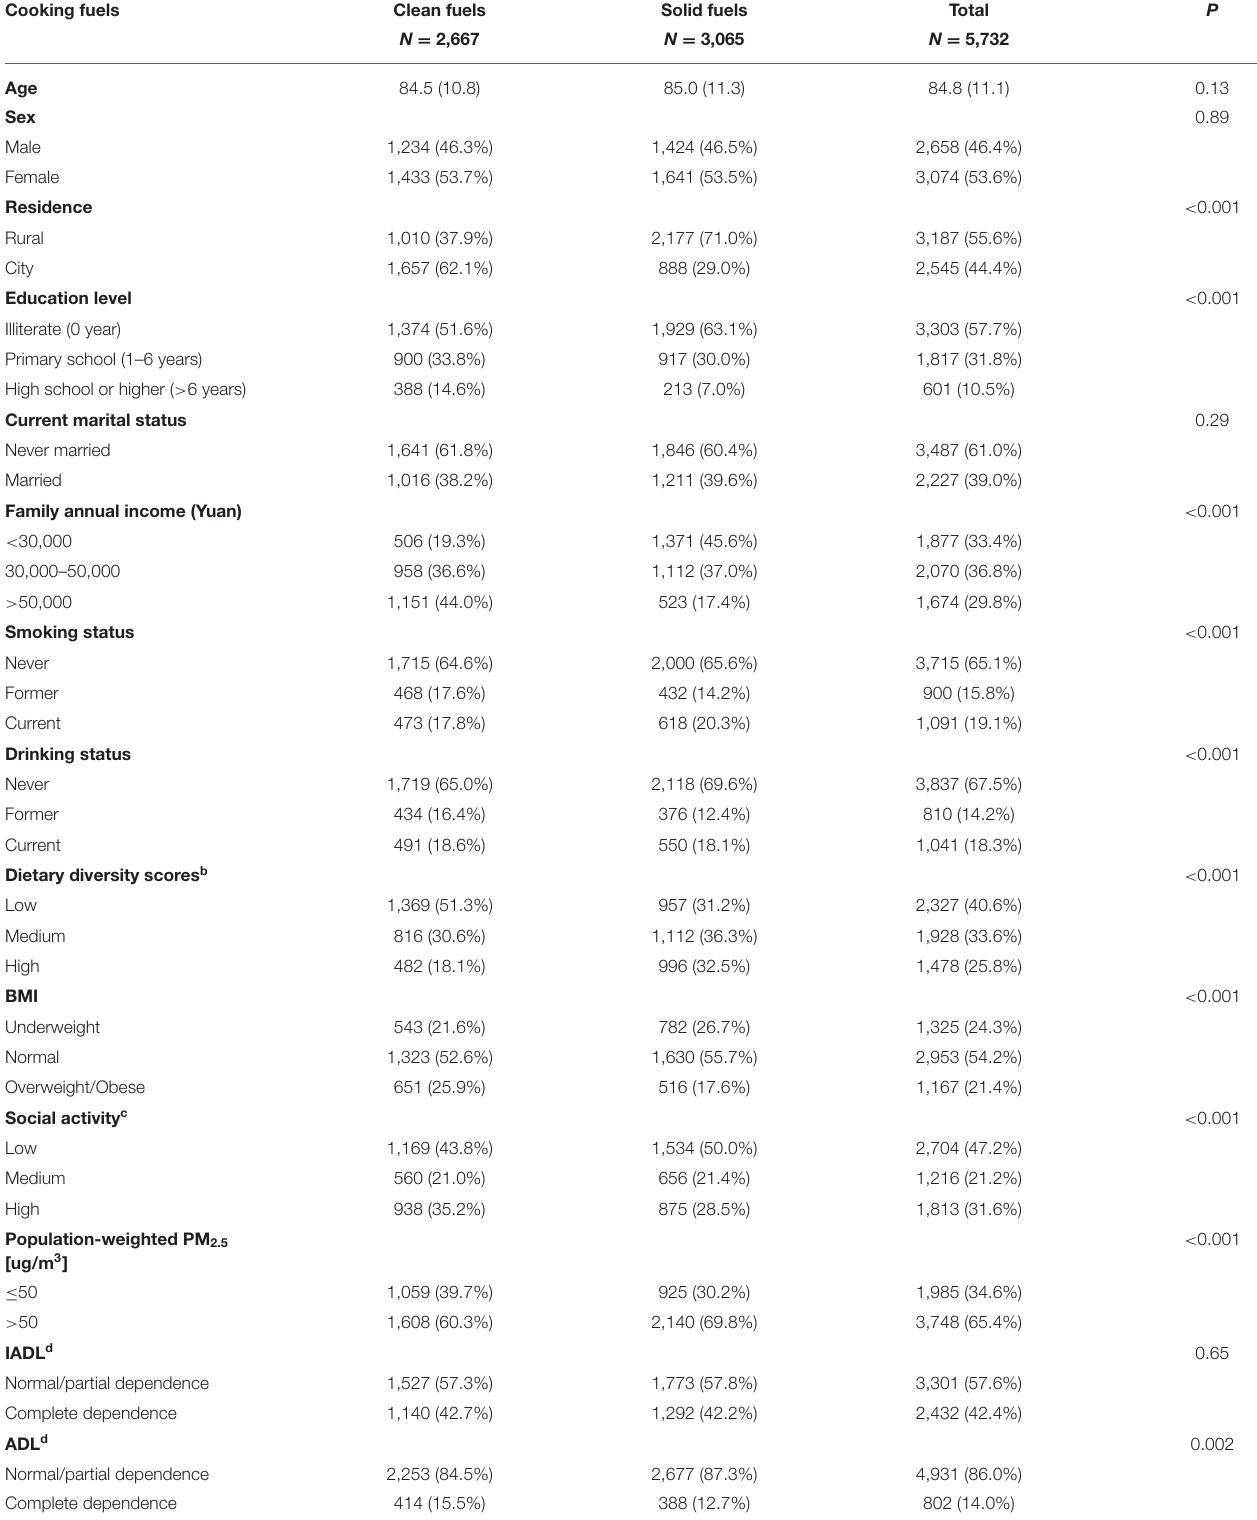
TABLE 1 | Characteristics of the study participants according to cooking fuel used at